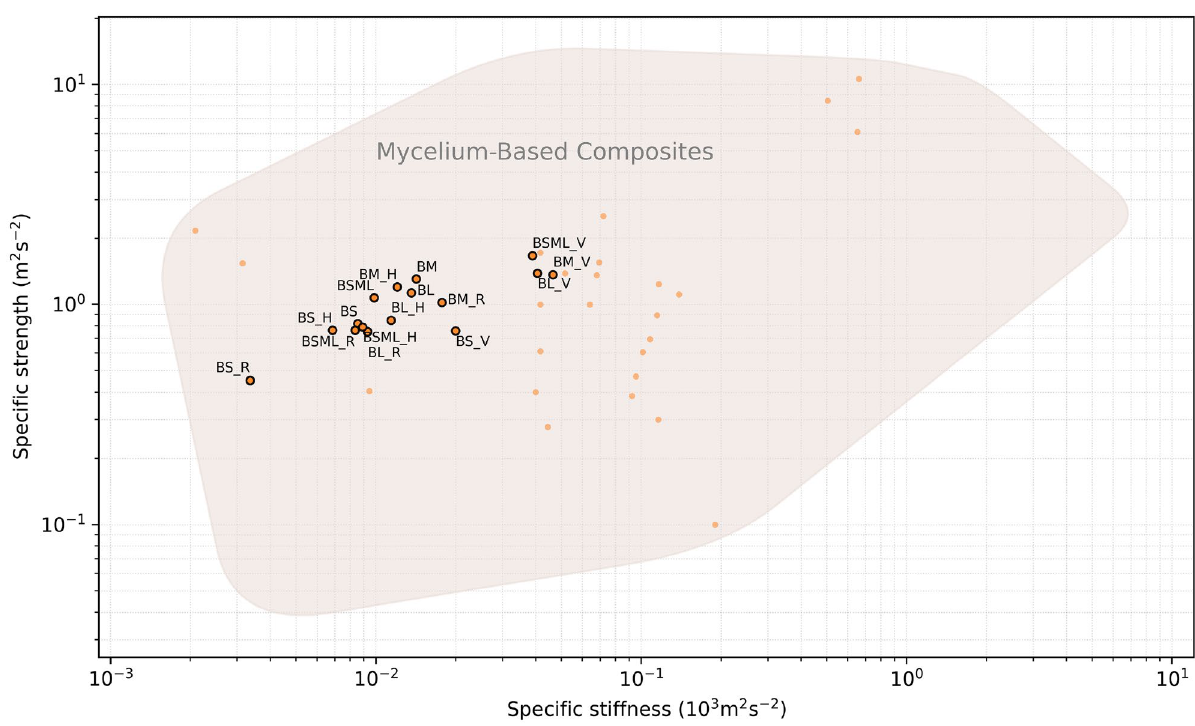
Figure 8. Specific strength results as a function of specific stiffness. Labelled data points: results from this study; unlabelled data points: reports from the